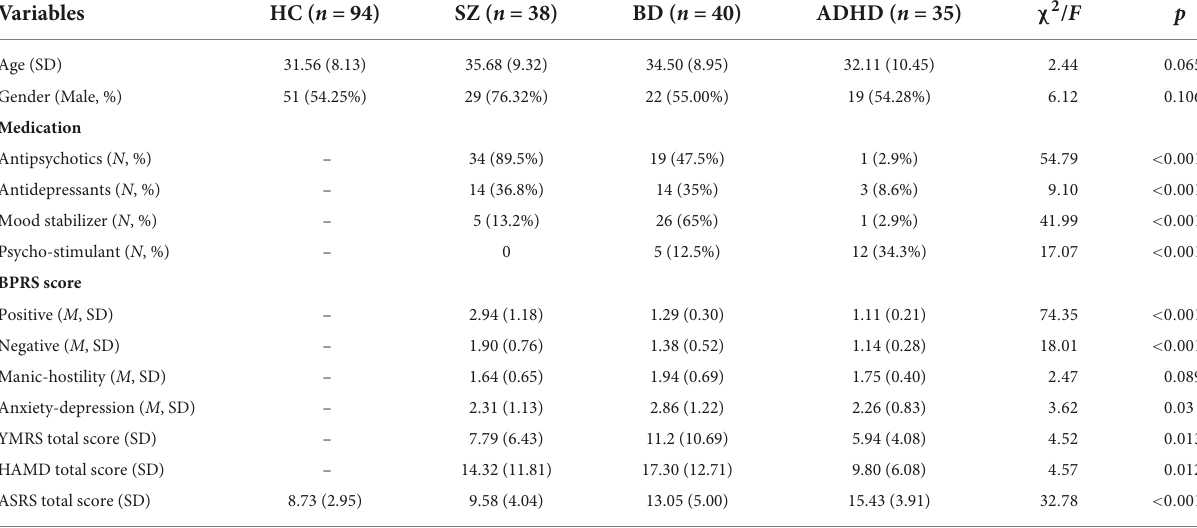
TABLE 1 Demographic variables and clinical characteristics of all participants.